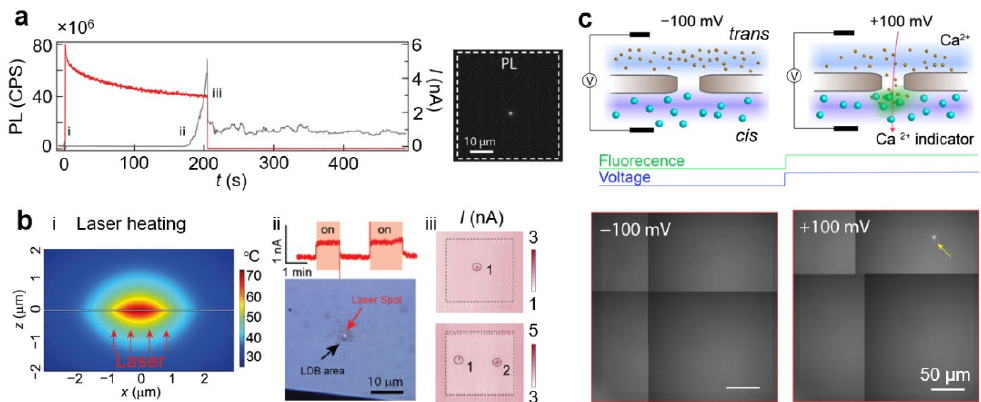
Figure 4. Additional approaches to provide feedback control in CBD. ( a ) Photoluminescence (PL) intensity provides the information of the membrane thickness. The PL intensity decreases over time indicating gradually reduced thickness of the membrane. A sudden drop of the PL intensity suggests the formation of the nanopore. Adapted with permission from Ref. [88]. ( b ) ( i ) Temperature profile of a 30 nm thick silicon nitride membrane when illuminated by a focused laser beam at 12 mW. ( ii ) The ionic current increases when the laser is focused on the nanopore due to the decreased viscosity at high temperatures. This increase in conductivity is reversible by turning the laser on and off. ( iii ) The ionic conductivity map when scanning laser position. The dashed circles highlight the regions where nanopores are located. Adapted with permission from Ref. [10]. Copyright 2018 American Chemical Society. Adapted with permission from Refs. [87]. Copyright 2021 American Chemical Society. ( c ) Schematic illustration showing that the Ca 2+ gradient and Ca 2+ -indicator report nanopore position. The cis chamber contains Fluo-8 and the trans chamber contains Ca 2+ ions. The fluorescence intensity increases locally when the Ca 2+ ions are electrophoretically driven through a nanopore (+100 mV). The fluorescence microscopy images on the bottom show a bright spot at the nanopore position (indicated by a yellow arrow) at positive applied potential. Adapted with permission from Ref. [10]. Copyright 2018 American Chemical Society.